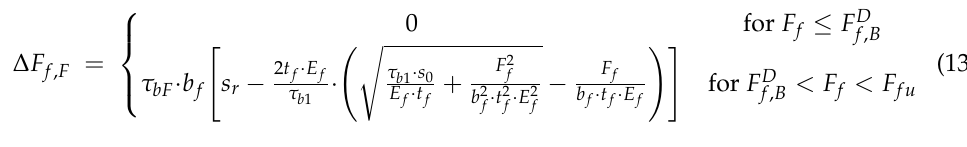
in the debonded area will increase the bond strength. The debonded length is calculated by deducting from the crack spacing an effective length, derived from the bilinear bond law (second branch of Equation (13)).